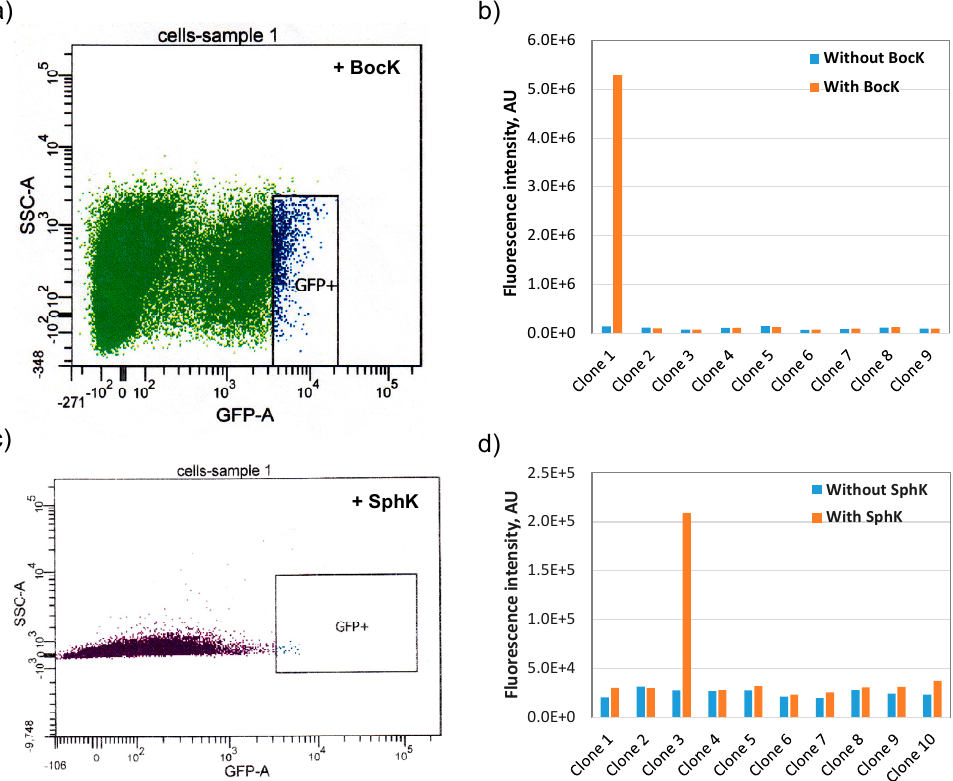
Figure 3. Identification of the active PylRS variants via FACS sorting. ( a , c ) Dot plots showing the sorting of Acella cells co-expressing the PylRS library and the fluorescent sfGFP-204TAG reporter in the presnce of ( a ) BocK or ( c ) SphK. The GFP+ cells rendered in blue were collected. SSC-A represents side scatter. ( b , d ) Fluorescence intensity of the cell lysates from the outgrowth of the randomly picked individual clones in LB medium after induction of protein expression in the presence of 1 mM of ( b ) BocK or ( d ) SphK. The GFP fluorescence was measured using a microtiter fluorescence plate reader with λ ex set at 485 nm and λ em set at 510 nm. 3. Discussion The screening strategy described here is based exclusively on bacterial sorting, utilizing the fluorescent reporter protein sfGFP equipped with an amber codon in its coding region. Together with the use of a dual-purpose Acella strain, the library generation, screening, and clone amplification and sequencing is extremely facile. With a suitably designed PylRS library in hand, the entire screen and verification can be completed within a week. Compared to the survival-based selection methods, the FACS-based screening method has several advantages. First, FACS is extremely sensitive in detecting low cellular fluorescence, which is particularly important during the screening of novel non-natural amino acids with modest substrate properties. For instance, in the FACS screening of SphK-specific PylRS variants, only ~1% of cells displayed modest sfGFP expression, with the mean fluorescence only 5-fold higher than the library mean (Figure 2d). Second, unlike the plate-based genetic screens in which stringency is controlled by antibiotic concentrations, the FACS-based screen allows for precise in-flight tuning of the selection parameters via appropriate placement of sort gates depending on the percentage of GFP+ clones in the library (Figure 3a and 3c), leading to a high degree of flexibility. Third, the FACS-based sorting is extremely fast, and up to 10 5 bacterial cells can be sorted per second using conventional sorters. For instance, we completed our FACS sorting of 6 million cells in 8 min. However, it is usually not practical to use FACS to screen large libraries with a size greater than 1 × 10 8 . One potential solution is to optimize the larger PylRS libraries through customized codon randomization based on the principle of “small-intelligent” mutagenesis, which dramatically reduces